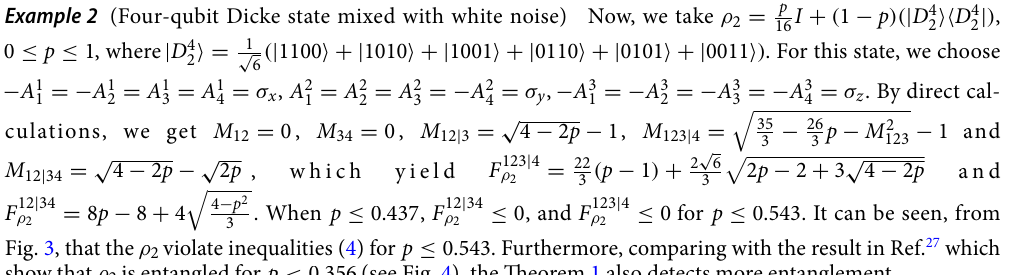
Fig. 3, that the ρ 2 violate inequalities (4) for p